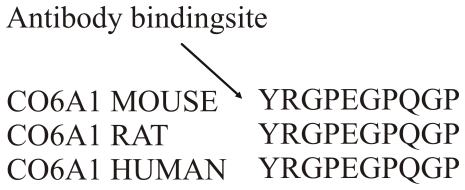
Alignment.Alignment of part of type VI collagen alpha 1 sequence for mouse, rat and human.